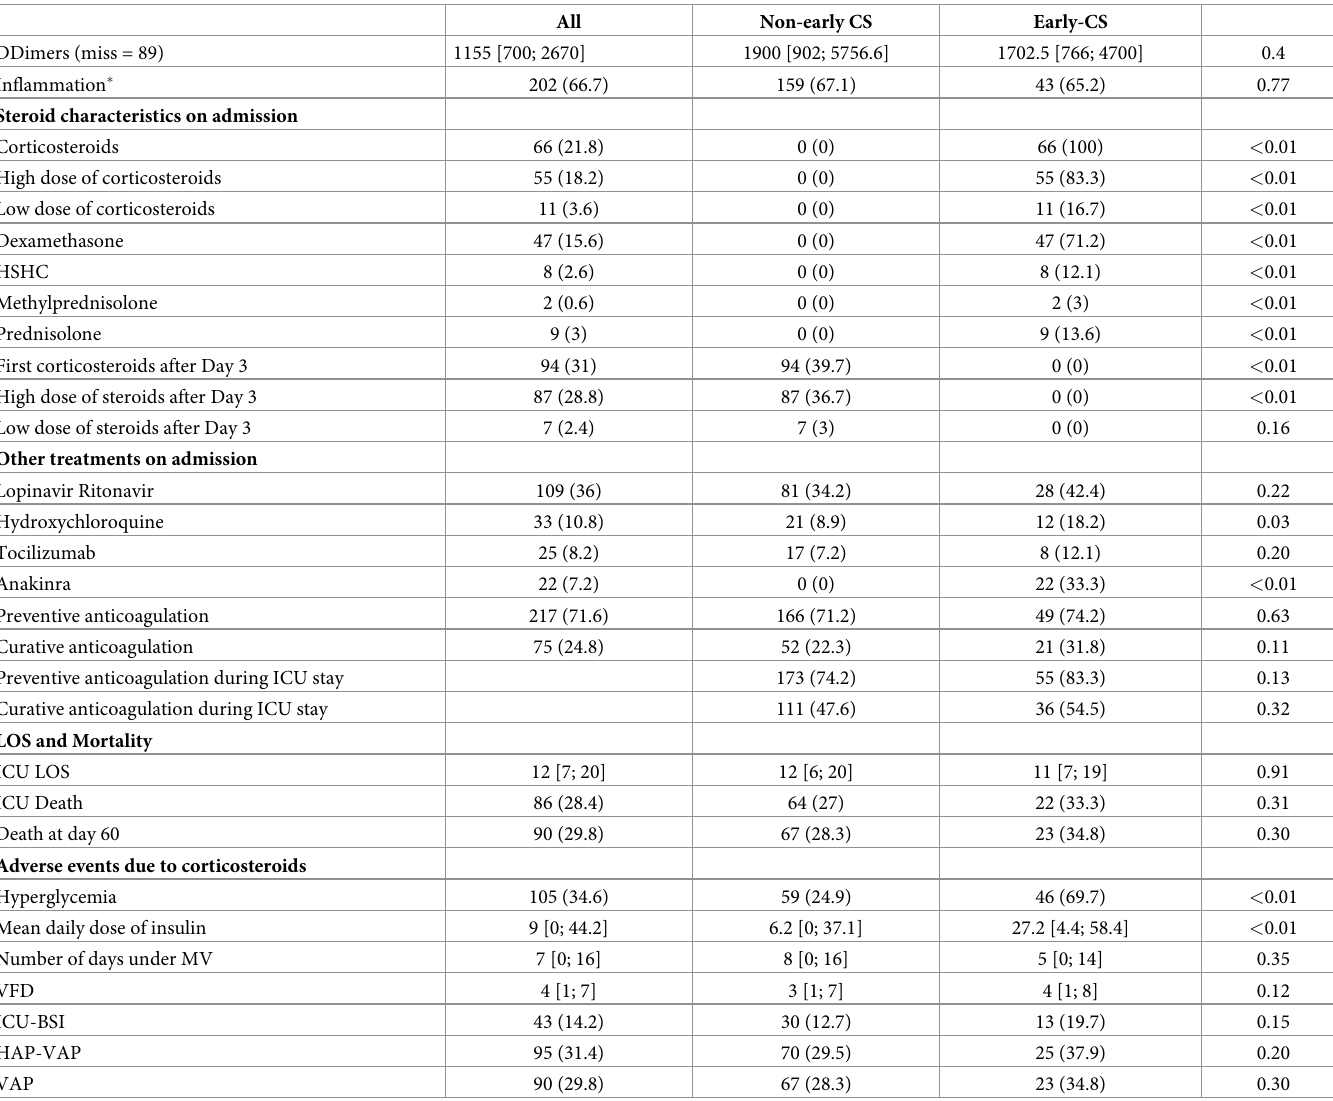
Sixty-six patients were in the Early-CS group including 47 patients receiving dexamethasone. In the Non-early-CS group, 94/237(39.7%) patients received corticosteroids during their ICU stay (S1 Fig). Lopinavir-ritonavir was administered in 109 (36%) patients, hydroxychloroquine in 33 (10.8%), tocilizumab in 25 (8.2%), and anakinra in 22 (7.2%). The comparison of baseline characteristics between the Early- and the Non-early-CS groups is shown in Table 1. Both groups had similar ICU ventilatory-free days, ICU-LOS and 60-day mortality. The